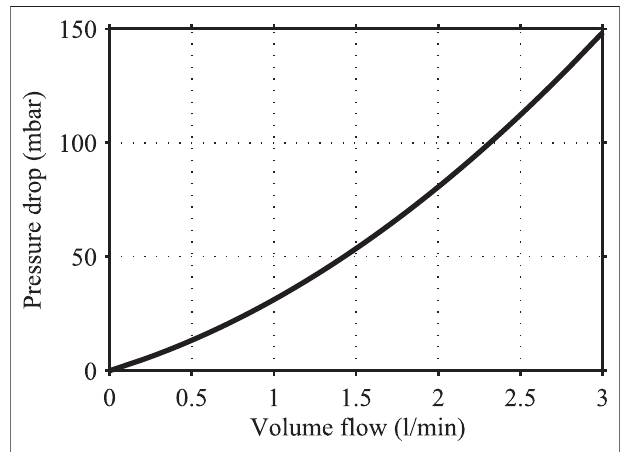
FIGURE 12 | Cooling channel pressure drop of the compressor with an integrated